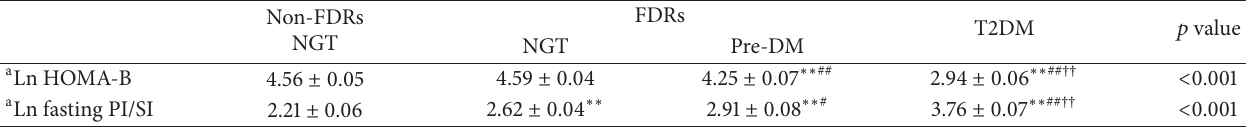
Table 3: Comparisons of 𝛽 -cell function after adjusting for